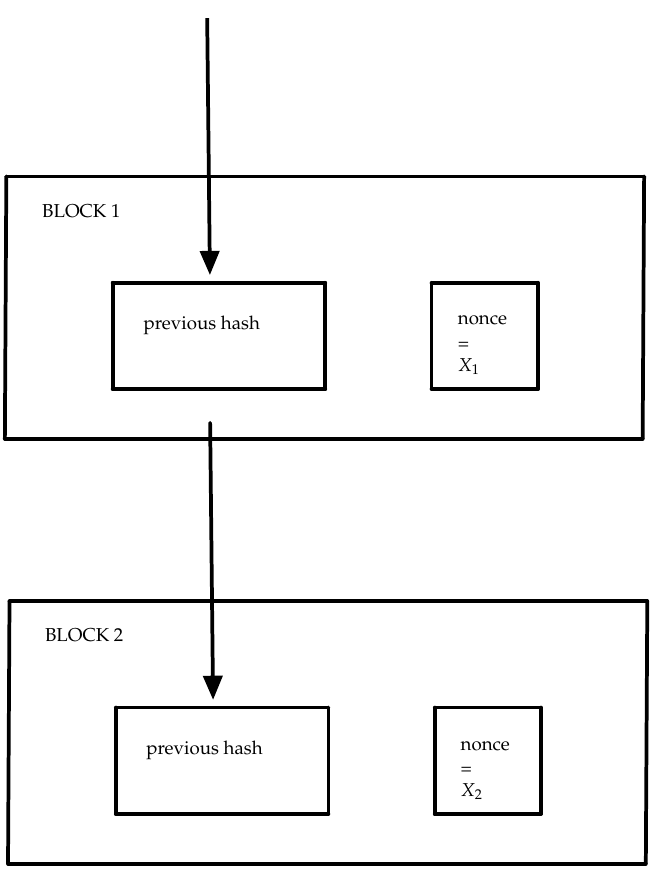
Figure 5. Proof-of-work system in the blockchain. Table 3. A genesis hash based on original Bitcoin’s inputs for genesis but using inflation propensity as